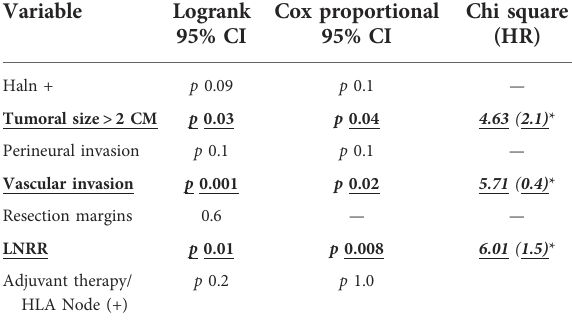
TABLE 4 Log rank and Cox regression analysis for